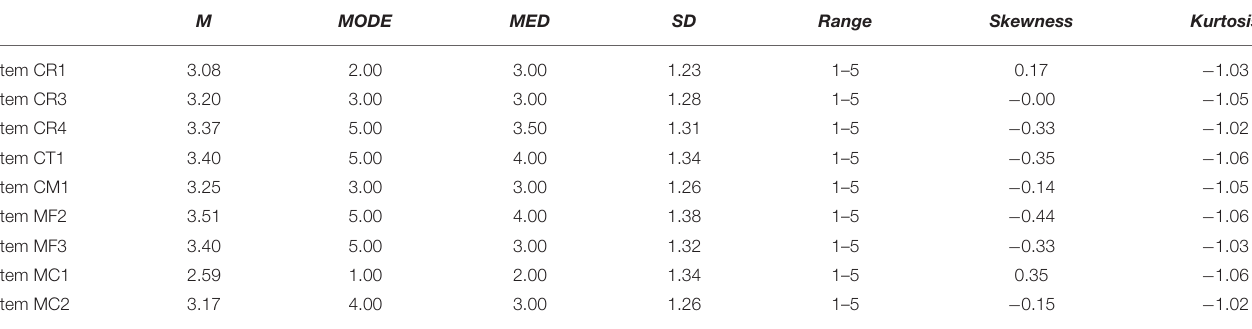
TABLE 2 | Skewness and Kurtosis scores for abnormal items of the CCI21. M